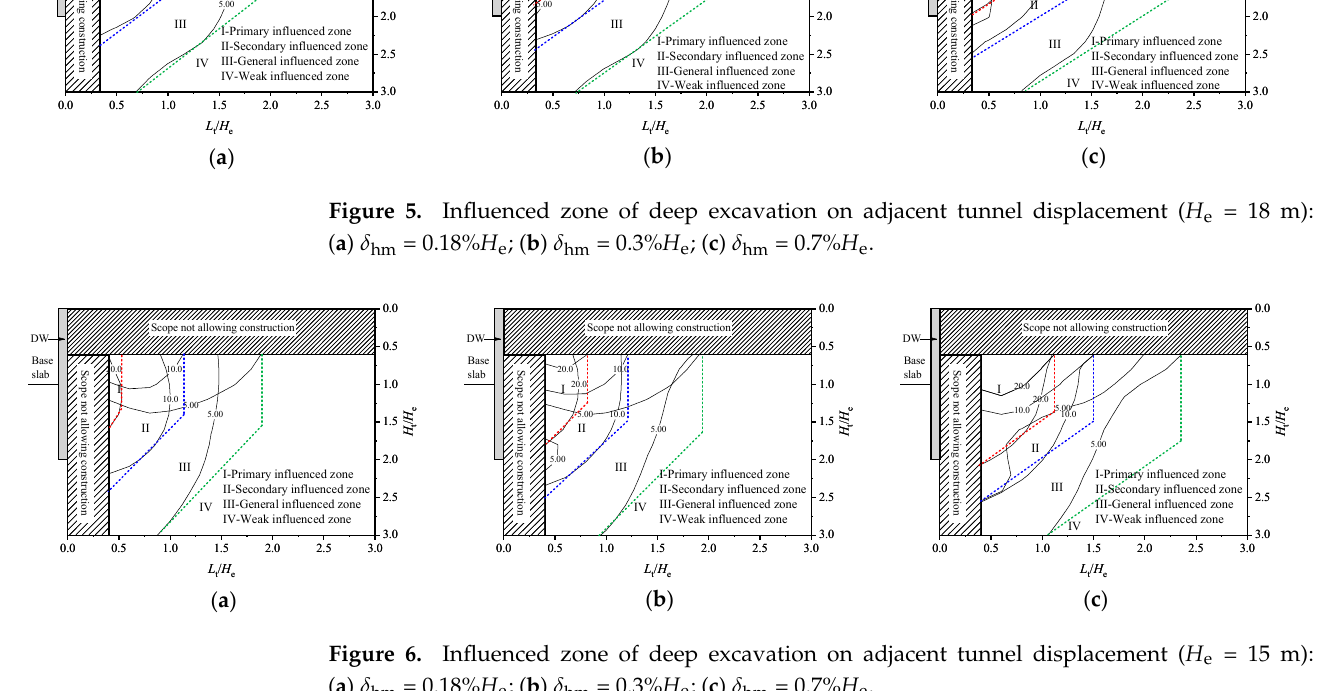
Figure 7. In fl uenced zone of deep excavation on adjacent tunnel displacement ( H e = 12 m): ( a ) δ hm = 0.18% H e ; ( b ) δ hm = 0.3% H e ; ( c ) δ hm = 0.7% H e .